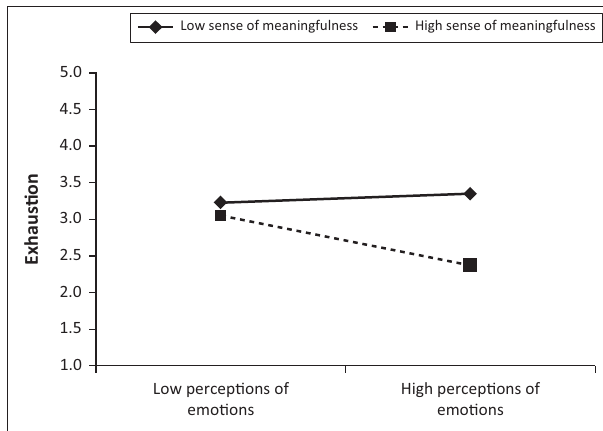
1.01.52.02.53.03.54.04.55.0